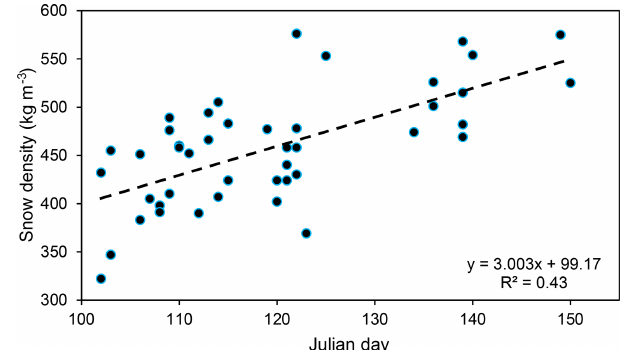
Figure 3. Snow density versus Julian day for all discrete snow pit and snow core locations ( n = 46). For our glaciological density- informed estimates, we use the observed glacier-wide snow density and a linear regression of density versus day and used the slope (3.0kgm − 3 d − 1 ( r 2 = 0 . 43)) and days between the survey and the observations to adjust for change in snow density (Table S1).